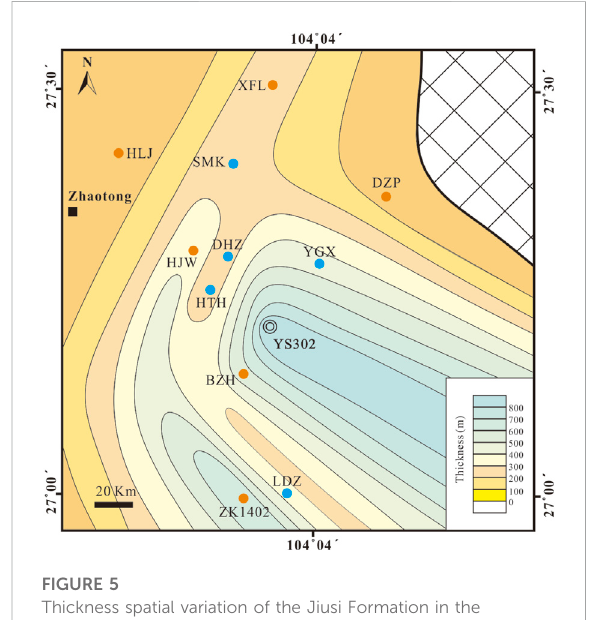
FIGURE 5 Thickness spatial variation of the Jiusi Formation in the northwestern Weining